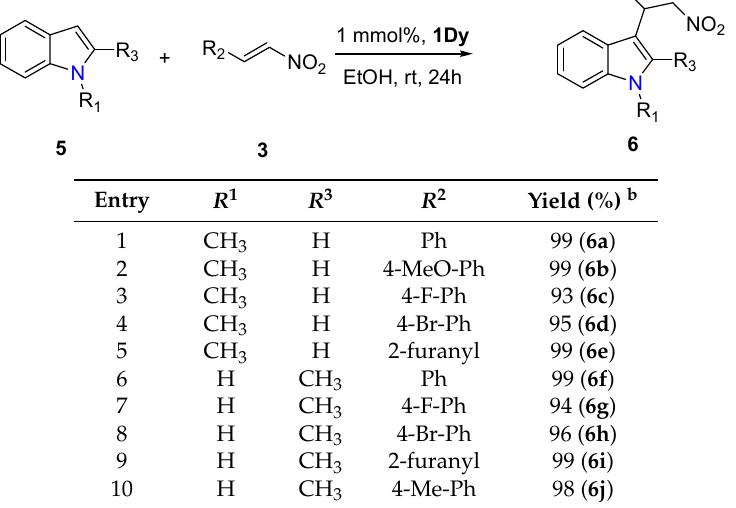
Table 3. Friedel–Crafts Alkylation of N ‐ alkylated and 2 ‐ methyl Indoles with Various Nitroalkenes a .